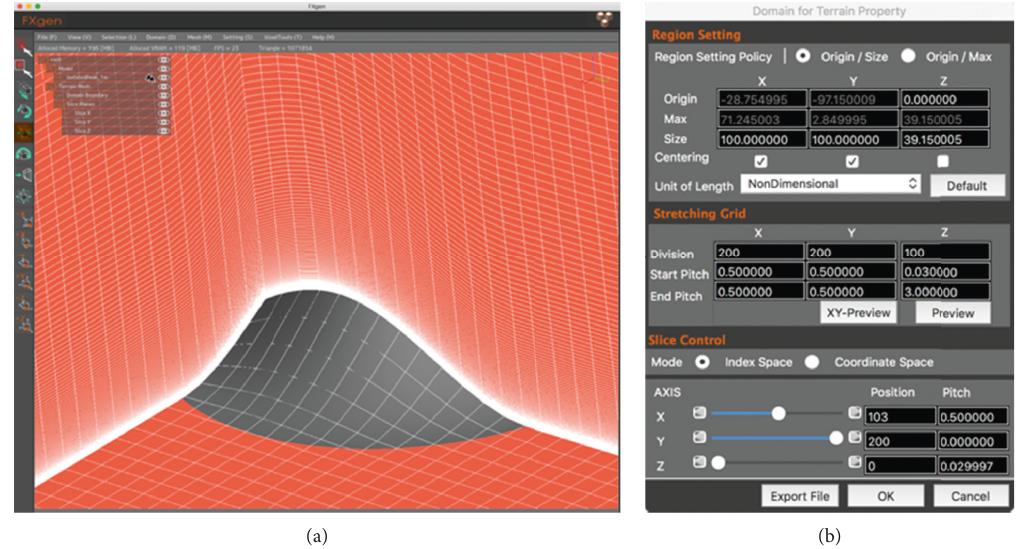
Figure 4: Exploration of meshing parameters with GUI application. (a) Screenshot of FXgen application. (b) Dialogue for parameter